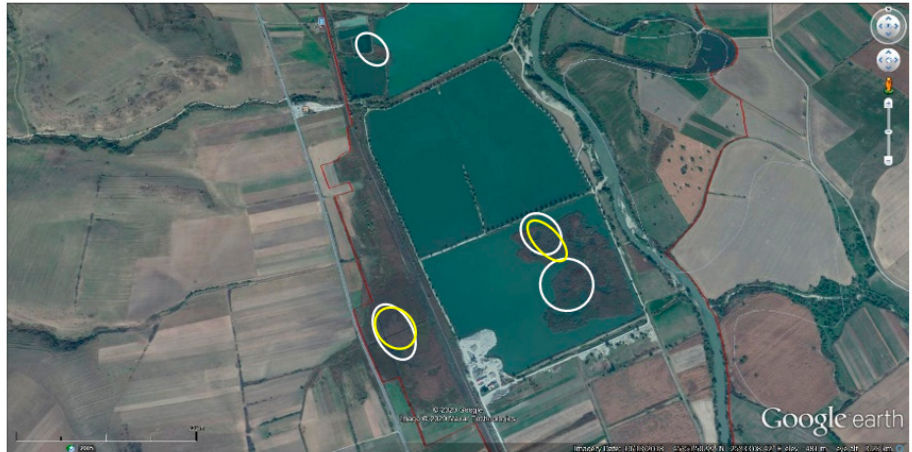
Figure 4. Colony location on fishponds and in marsh from Rotbav, 2010–2020 (yellow oval, Ardea alba ; white oval, A. cinerea , A. purpurea ).